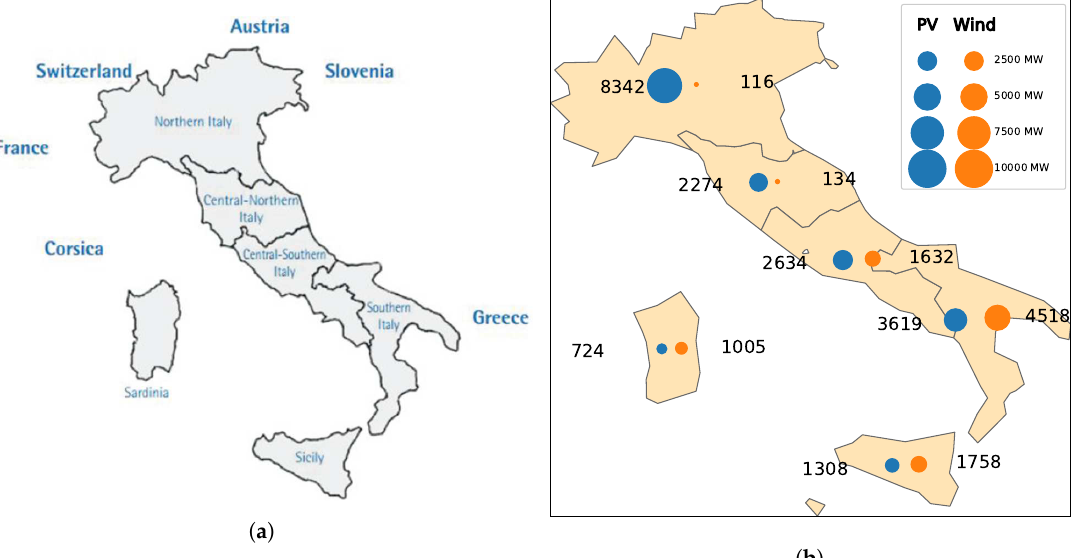
Figure 3. ( a ) Italian bidding zones. ( b ) PV and wind capacities installed by the end of 2015 in Italy (from Terna, see Appendix A.1). Capacities are graphically represented by the size of the disks and the corresponding legend and explicitly given in megawatts by the text boxes to the left and to the right of the